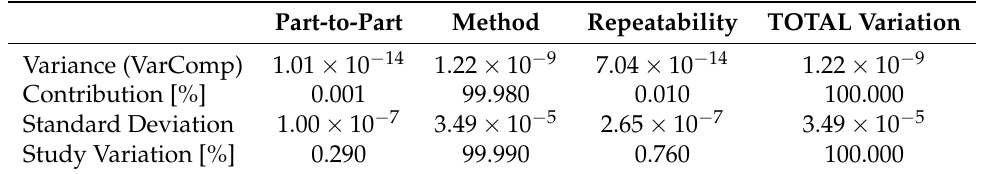
Table 9. Gage R&R significance result for Jcc without optimization.